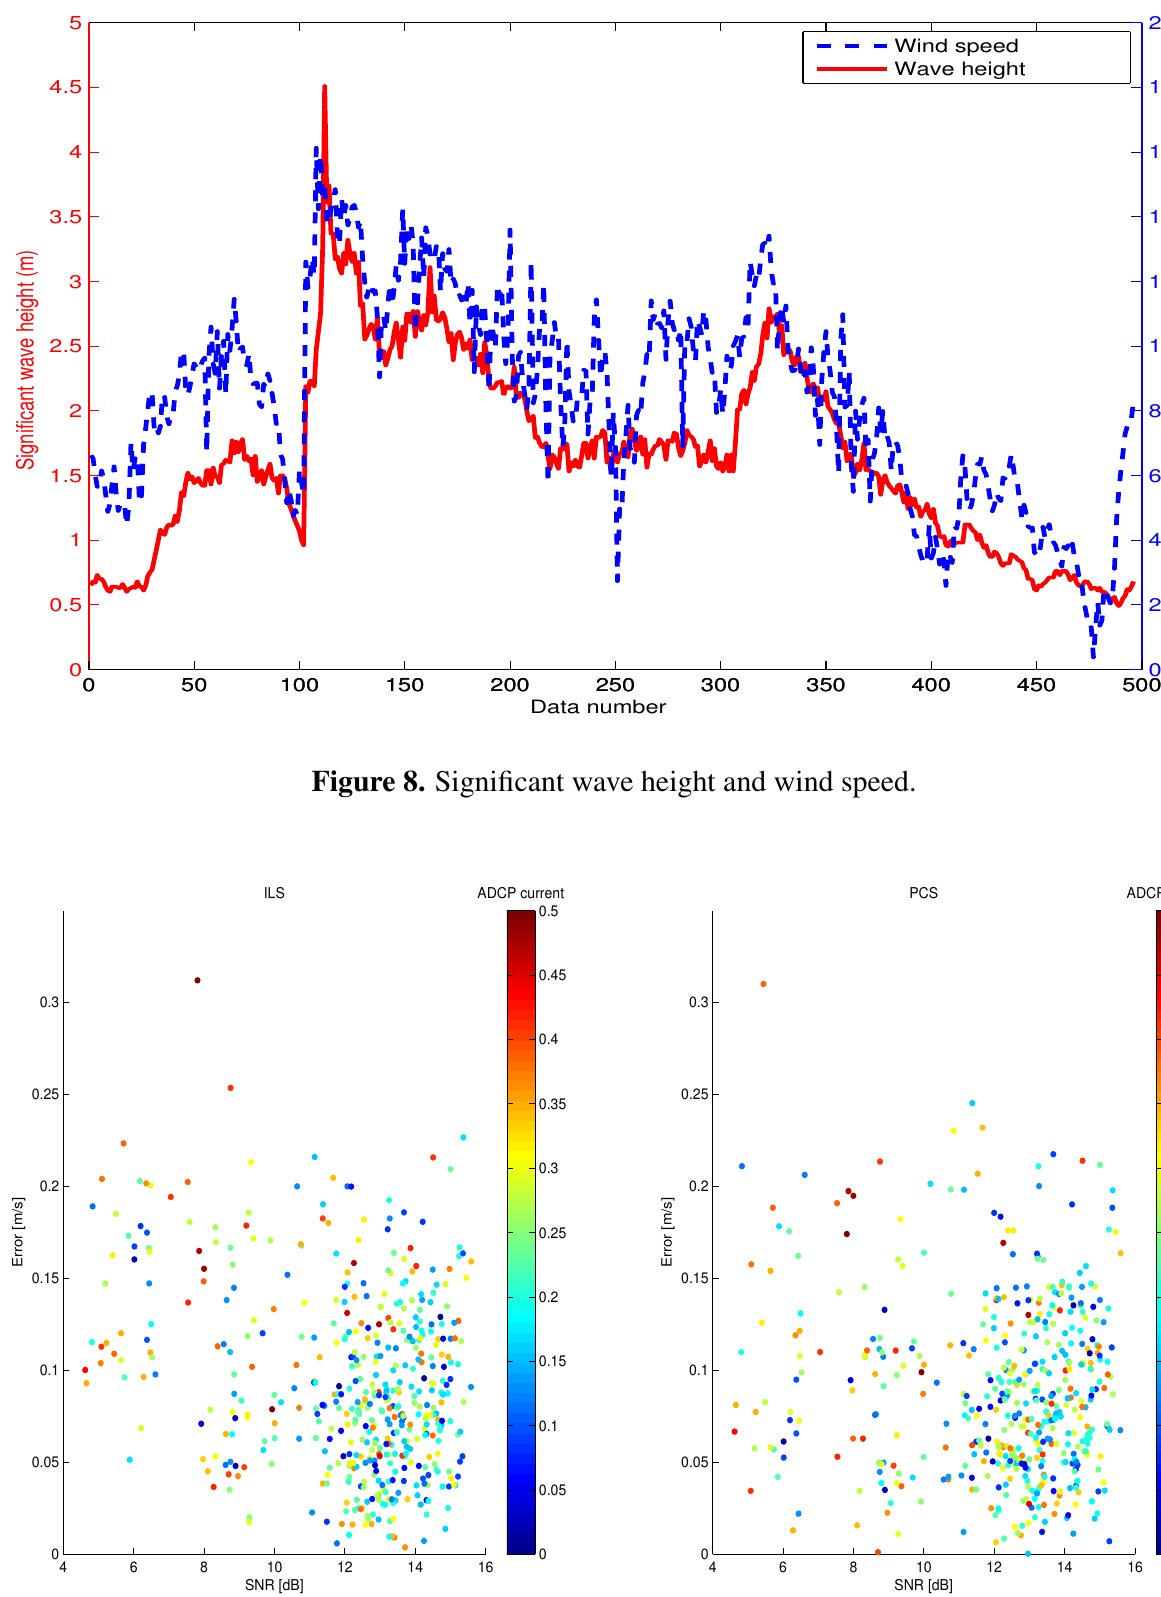
Figure 9. Dependence of current speed error on SNR for the method of ILS ( left ) and PCS ( right